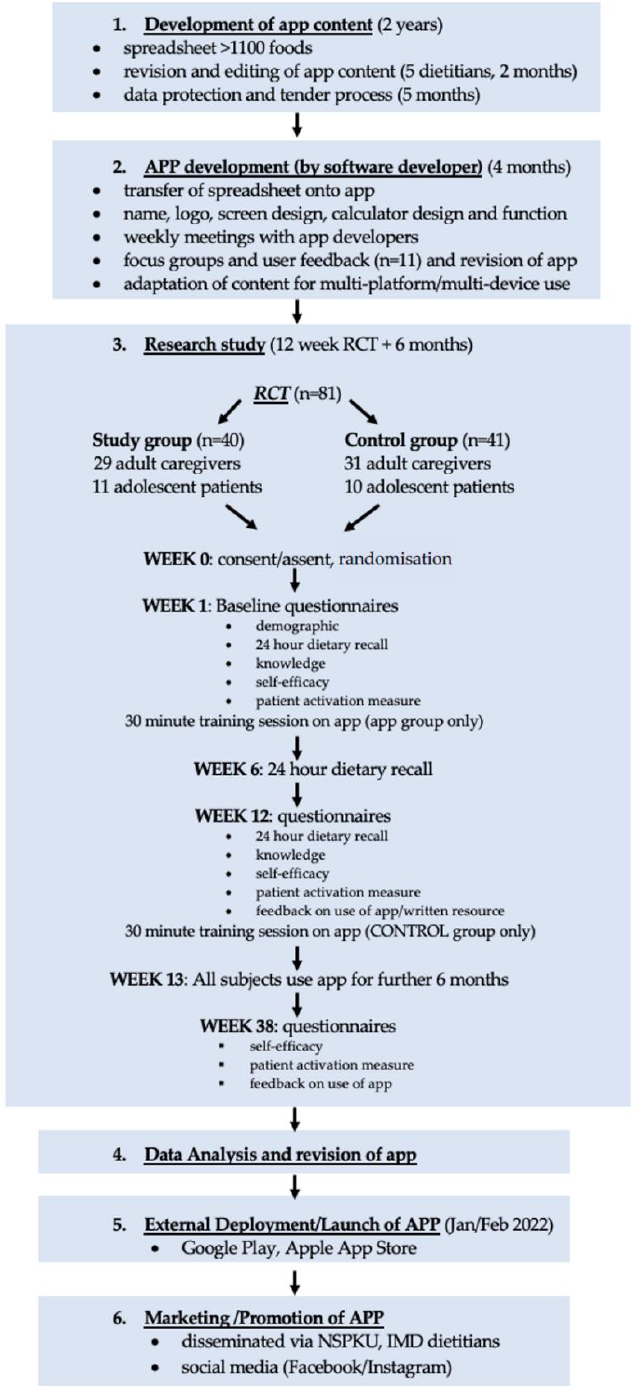
Figure 1. App study design and development procedures. (Abbreviations: RCT = Randomised Con- trolled Trial; NSPKU = National Society for Phenylketonuria; IMD = Inherited Metabolic